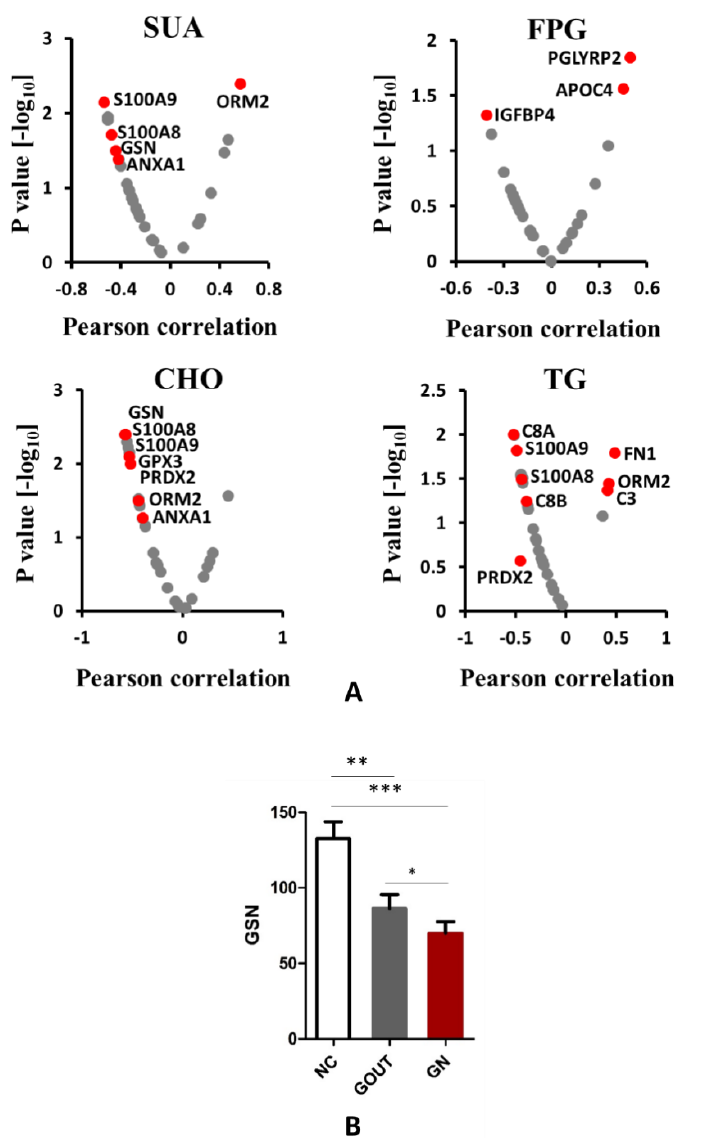
Figure 6. ( A ) Correlation between abnormal plasma proteins and clinical biochemical index in patients with gout. ( B ) ELISA confirmation of protein GSN between the normal control group and gout groups. Data were expressed as the mean using GraphPad Prism. * p < 0.05, ** p < 0.01, *** p < 0.0001.